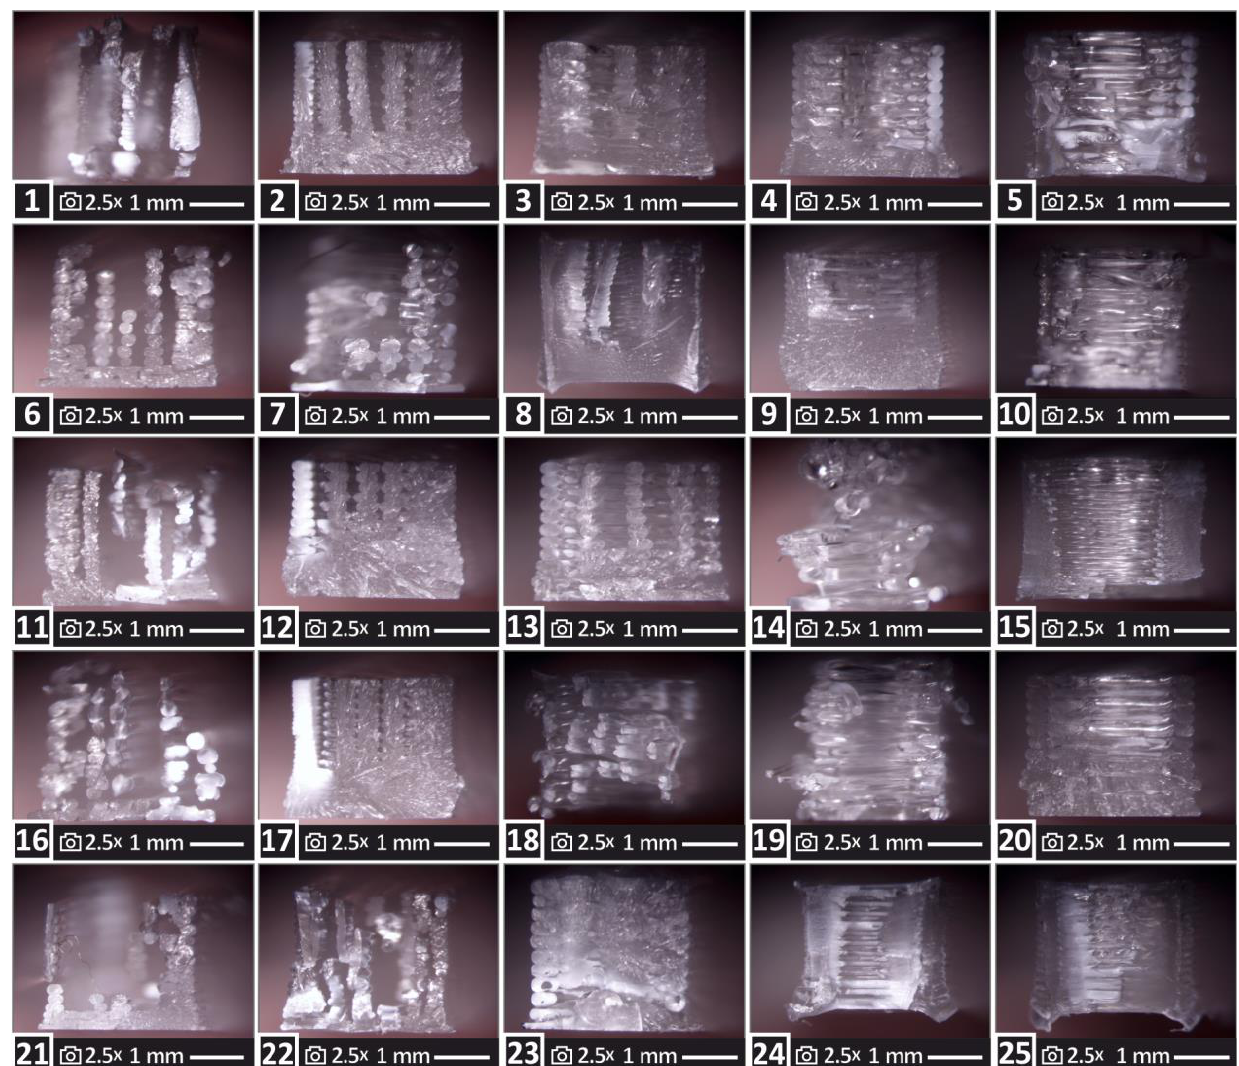
Figure 4. Images from the optical stereoscope of the fracture surface of one of the five samples for each one of the twenty-five runs studied in the work. The number in the images is the corresponding run from which the image was taken.